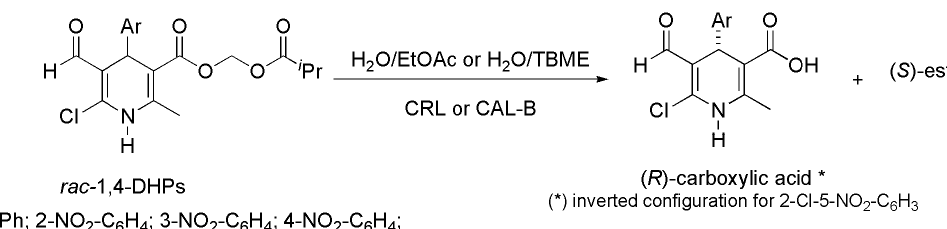
Table 1. Enzymes and conditions used on the kinetic enzymatic hydrolysis of rac -Ketoprofen vinyl ester by methods a and b. Method Enzyme Conditions Reference